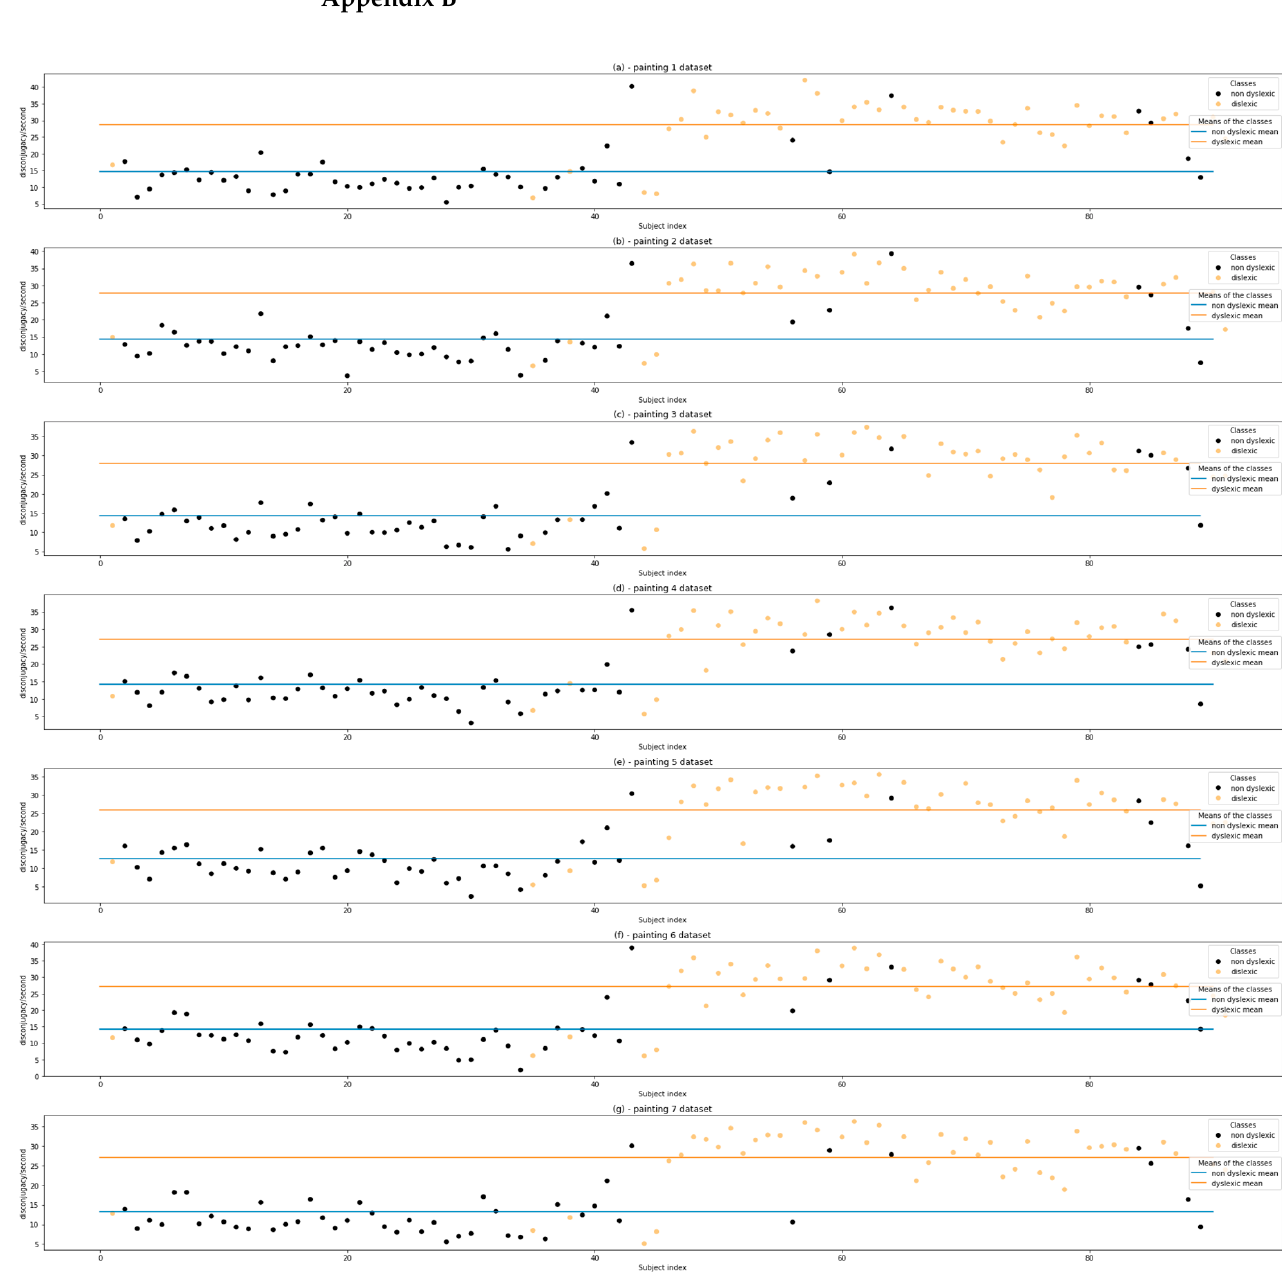
Figure A2. DGI. Subfigure ( a – g ) present the DGI score for each patient for the Painting 1, 2, 3, 4, 5, 6, 7 Dataset,